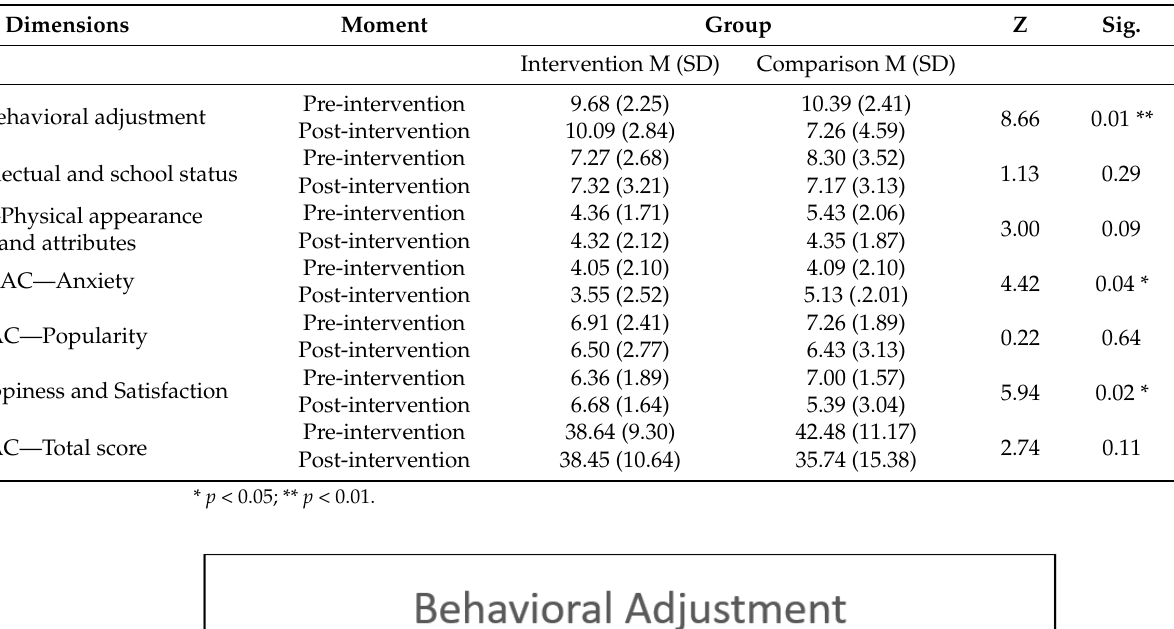
Table 1. Self-concept dimensions in IG and CG at pre-intervention and post-intervention.